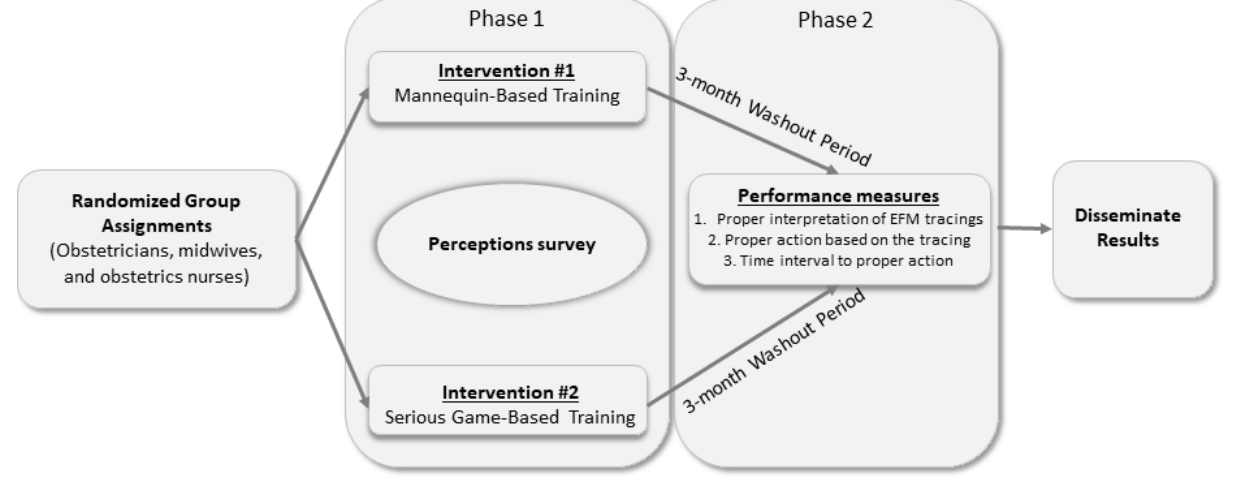
Figure 2. Study design flow diagram. EFM: electronic fetal